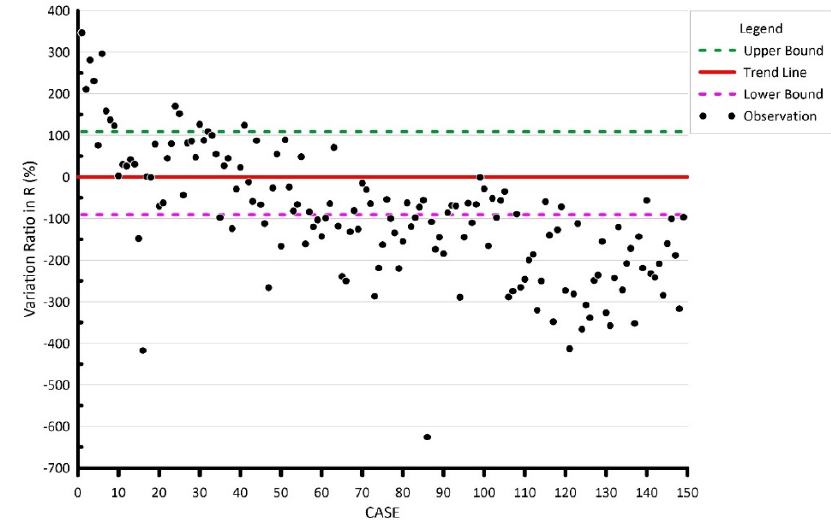
Figure 10. Prediction of rainfall distribution by linear analysis of 79 LSL cases.